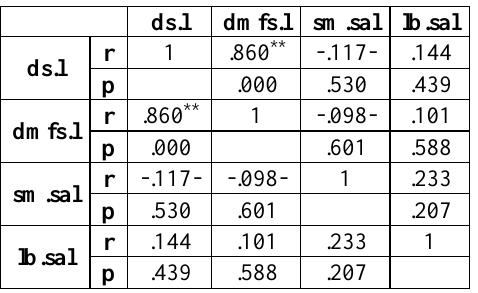
Table 1: The descriptive statistics for decayed surfaces and decayed missing filling surfaces in upper and lower primary and